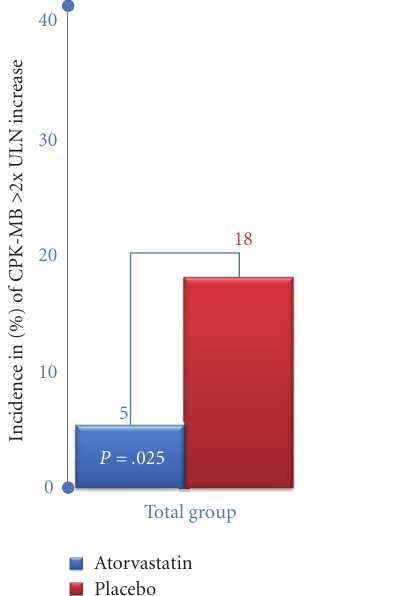
Figure 6: ARMYDA-CAMs study. This modified graphic of the ARMYDA-CAMs study showed that, in a preselected subgroup or the ARMYDA-Original study, in individuals with stable coro- nary syndromes, statin-na¨ıve, and undergoing elective PCI, the administration of atorvastatin 40mg/7 days before PCI significantly reduced the percentage of elevation 24 hours after PCI of ICAM and E-selectin. This reduction was not observed with VCAM (not shown in the